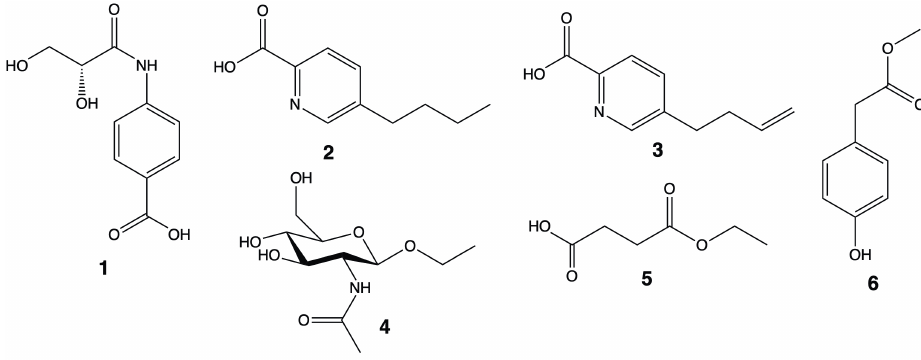
Figure 1. Structures of compounds 1 – 6 .